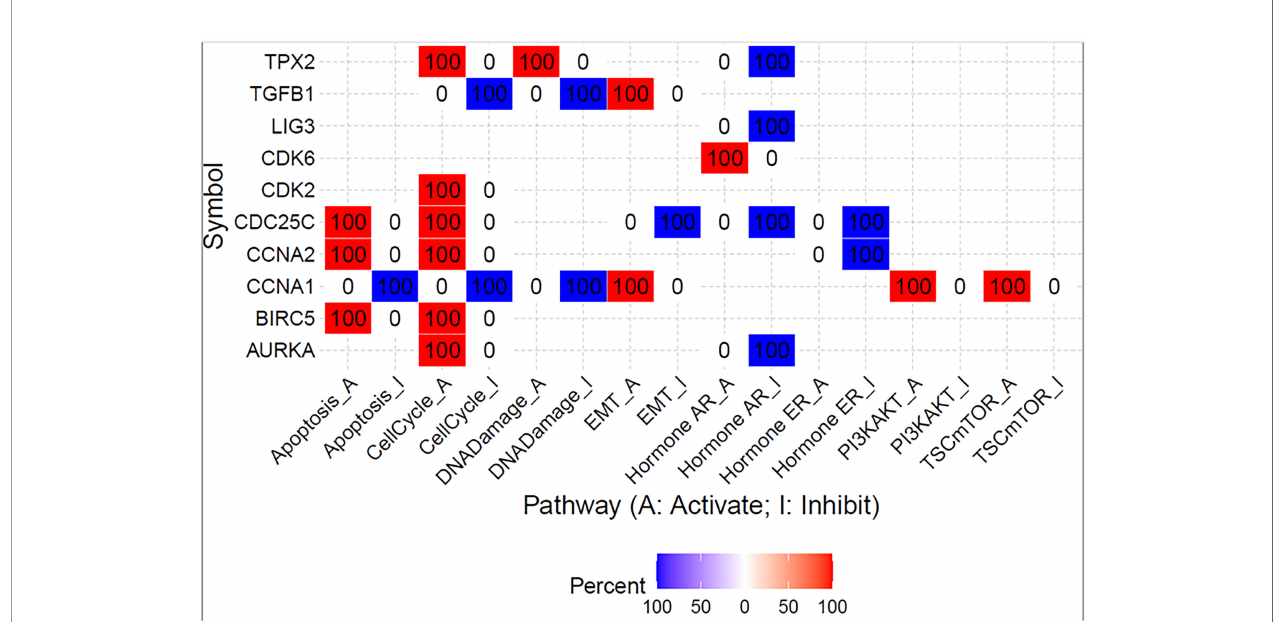
FIGURE 7 | Summary of the percentage of colon adenocarcinoma in which shared gene expression has a potential effect on pathway activity. The analysis was created using Gene Set Cancer Analysis (GSCALite) web tool and TGCA PanCancer COAD dataset.